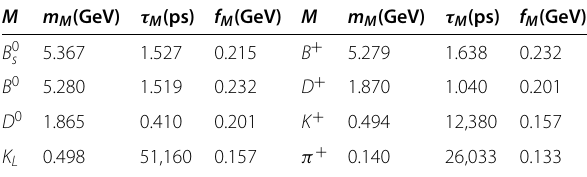
Table 4 A summary of input parameters for the involved